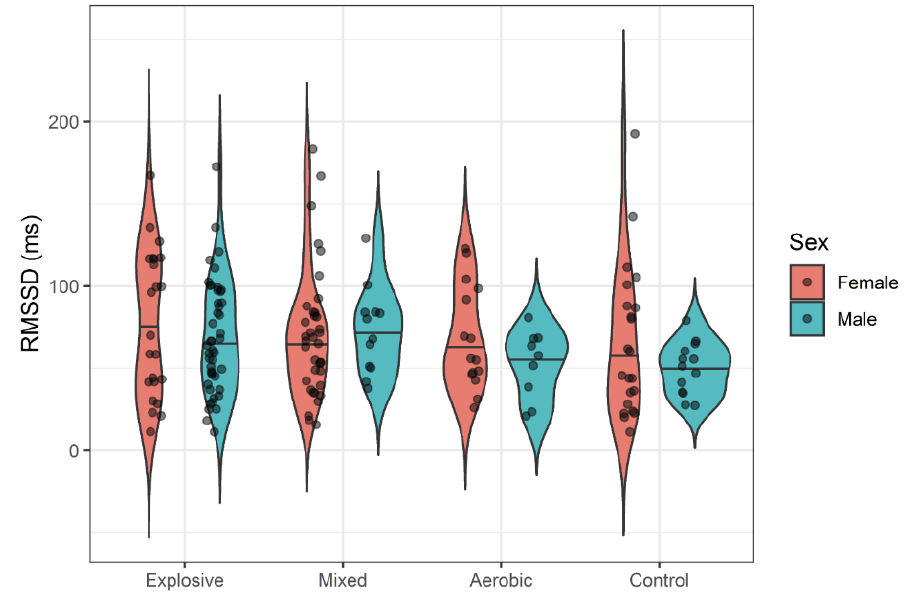
Figure 3. RMSSD by Athlete Type.